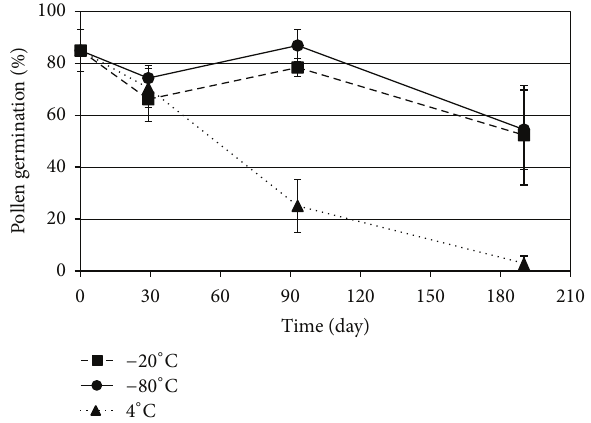
Figure 1: Pollen germination rate (%) of “Fuji” under three temper- ature conditions (4 ∘ C, − 20 ∘ C, and − 80 ∘